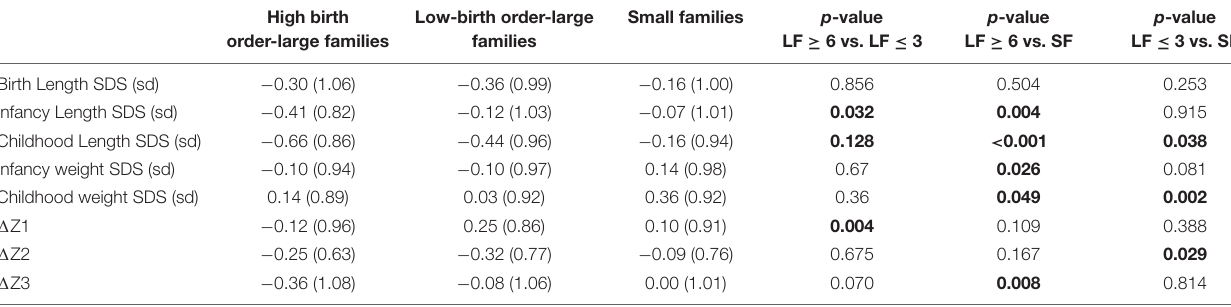
TABLE 2 | Comparison of the main study variables between all children included in the